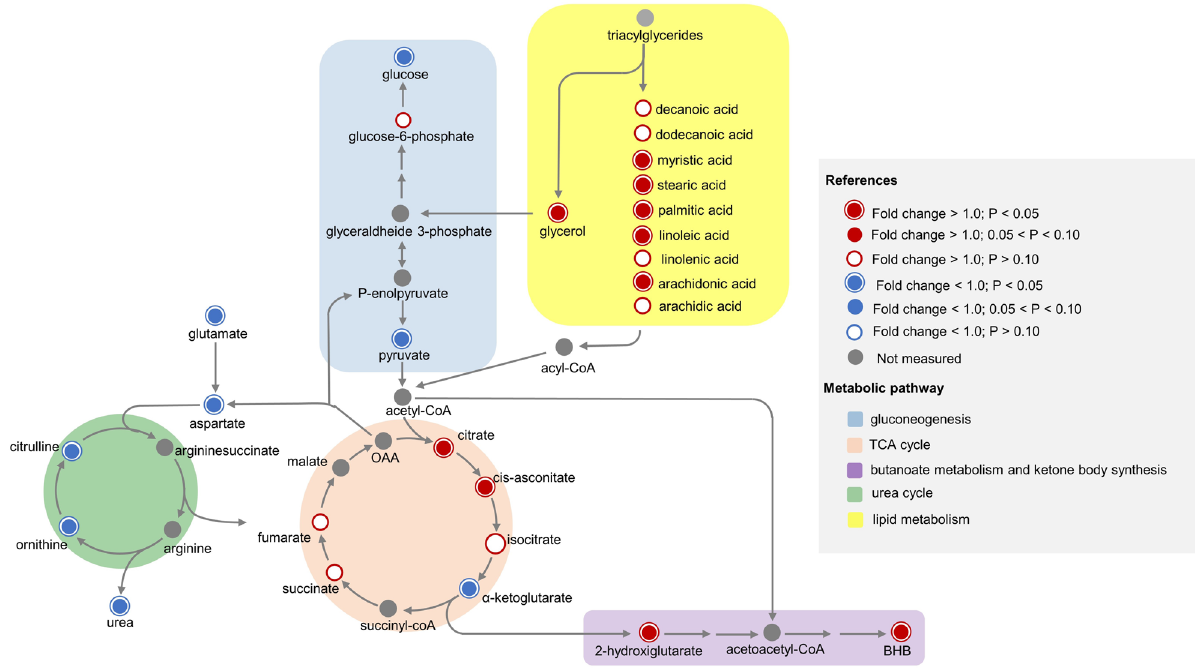
Figure 4. Main metabolic pathways identified to be differentially regulated at early vs. mid lactation stage (21 vs. 180 days in milk) according to metabolic pathways analysis performed on blood plasma metabolomic data of multiparous Holstein cows under grazing conditions. Colored circles depict effectively measured compound, while gray circles correspond to undetected ones. Negative and positive fold changes for each metabolite when comparing 21 vs. 180 days in milk are denoted by blue or red circles, respectively. Color background group metabolic pathways indicated in the figure legend, as well as significance levels.